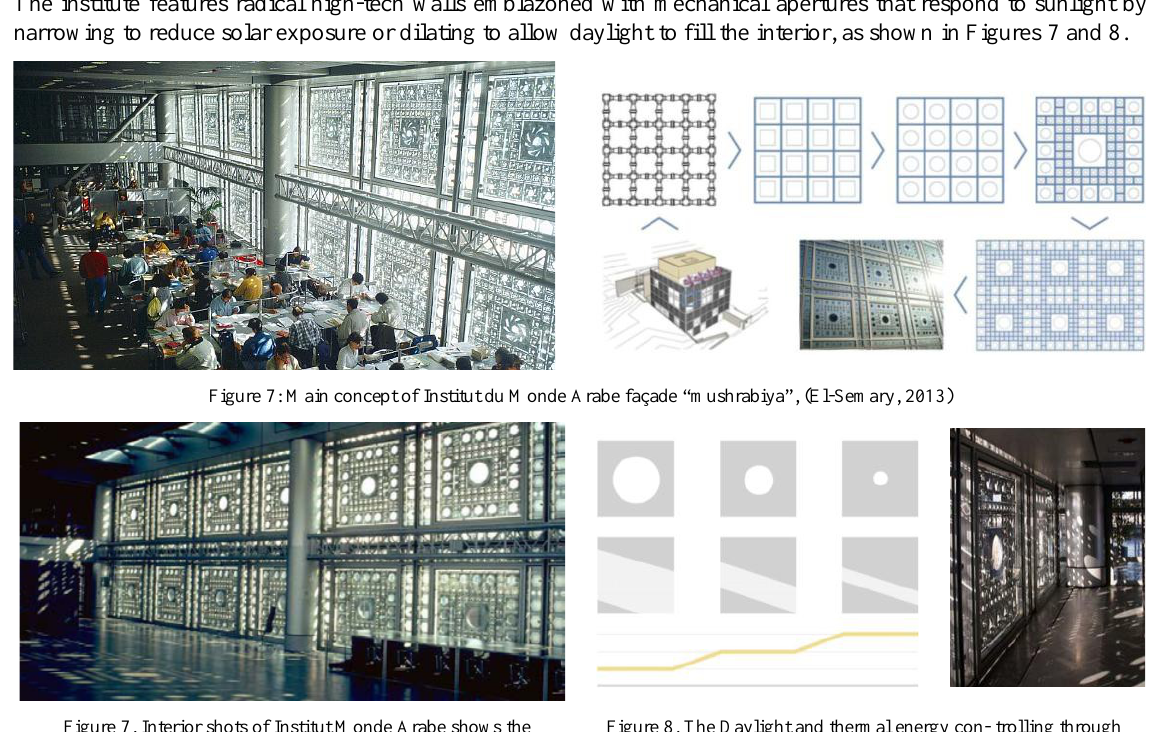
Figure 7. Interior shots of Institut Monde Arabe shows the Figure 8. The Daylight and thermal energy con- trolling through sensitive diaphragms which regulate the amount of daylight the responsive kinetic façade (El-Semary, entering the building